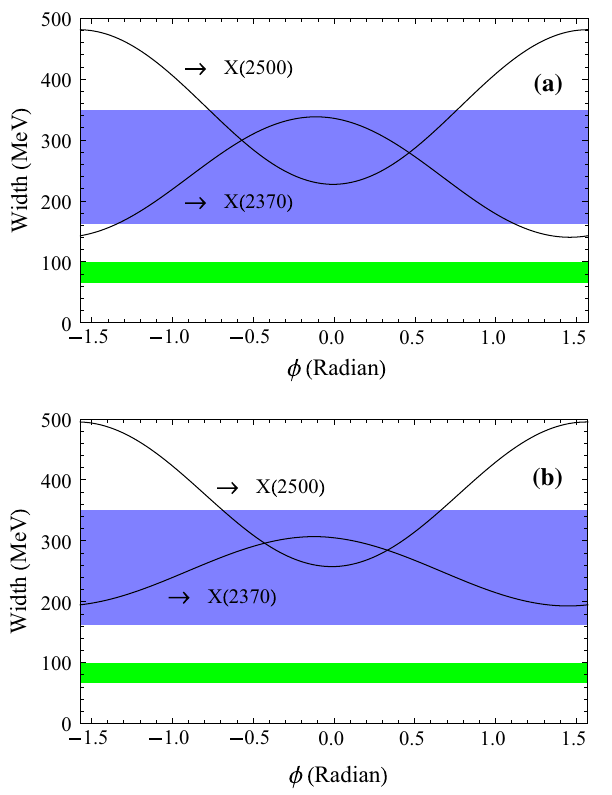
Fig. 4 The total widths of the X ( 2370 ) and X ( 2500 ) dependence on the φ in the 3 P 0 model with two types of wave functions: a with the SHO wave functions b with the RQM wave functions. The blue and green band denote the measured widths for the X ( 2500 ) and X ( 2370 ) , respectively [1,3]